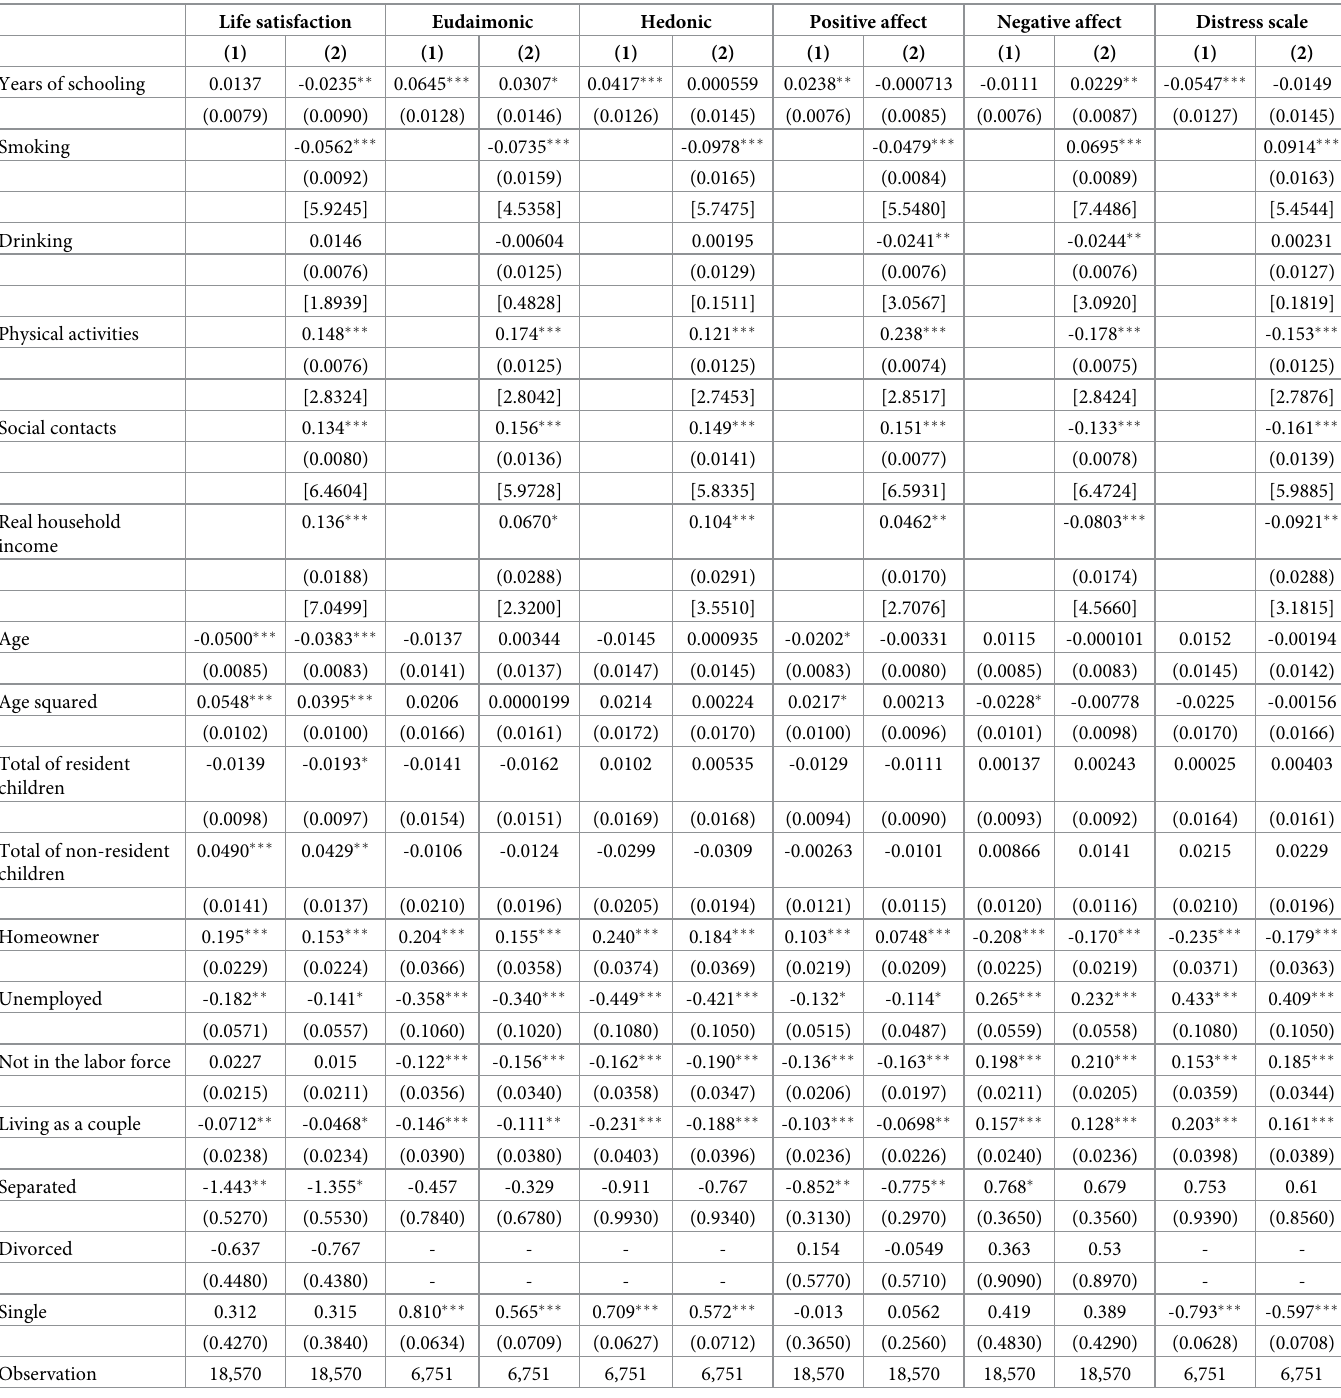
Table 7. Mediation